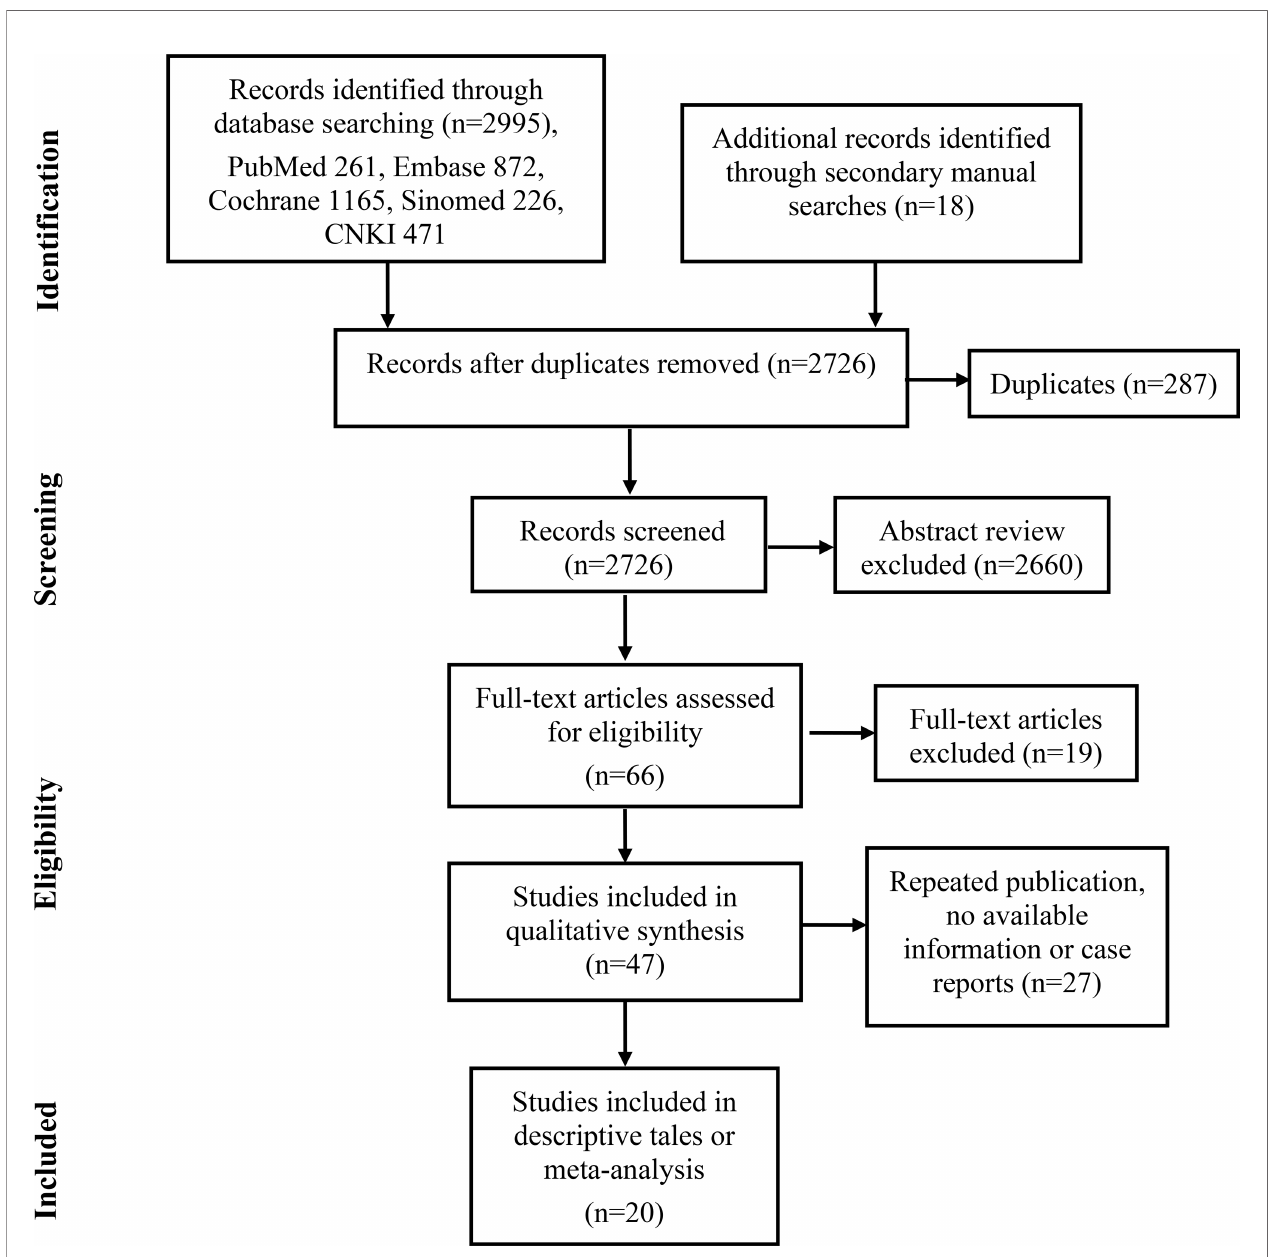
FIGURE 1 | The fl ow diagram illustrates the screening and evaluation process (adapted from the PRISMA